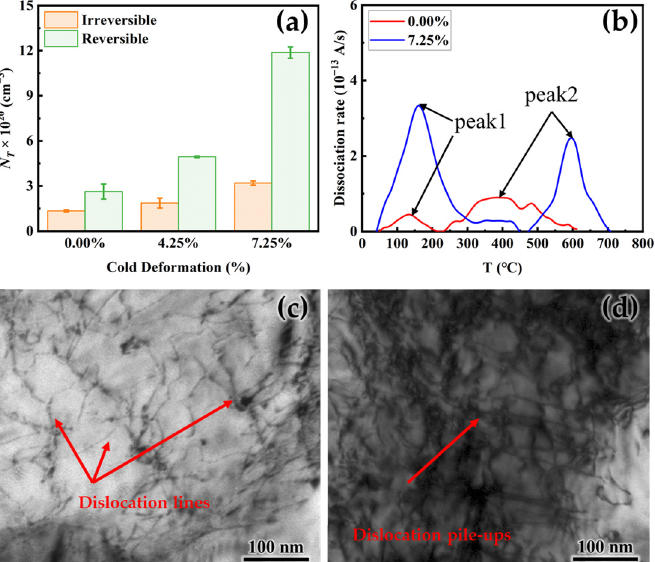
Figure 7. ( a ) Hydrogen trap density diagram for X65 pipeline steel from the electrochemical hydrogen permeation test, ( b ) TDS curves for X65 pipeline steel with different cold deformation levels, ( c ) TEM micrographs of X65 steel with 4.25% cold deformation, ( d ) TEM micrographs of X65 steel with 7.25% cold deformation.